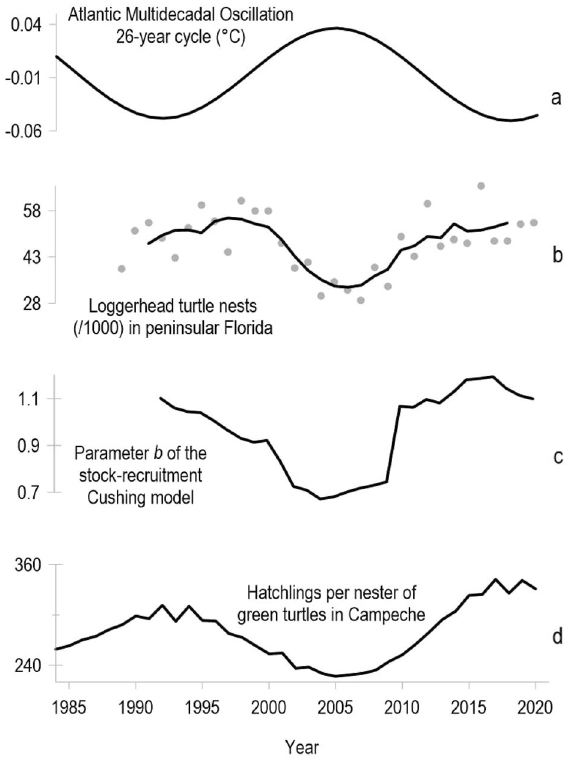
Figure 3. From top to bottom: ( a ) time series of a 26-year cyclic component of the Atlantic Multidecadal Oscillation Index (AMO, an index of sea surface temperature over the Atlantic Ocean in the Northern Hemisphere); ( b ) raw data (gray dots) and smoothed version (black line) of loggerhead turtle nests (/1000) in peninsular Florida; ( c ) parameter b of the Cushing stock-recruitment model (indicative of the hatchling production regime), fitted by local regression (9-year windows) using hatchling and nester abundance data 1984–2020 of the green turtle ( Chelonia mydas ) population from Campeche, Mexico; ( d ) the estimated recruitment rate for the green turtle (number of hatchlings per nesting female, Eq. (4)) derived from the extended Cushing model. The time series of parameter b from local regressions span from 1992 to 2020